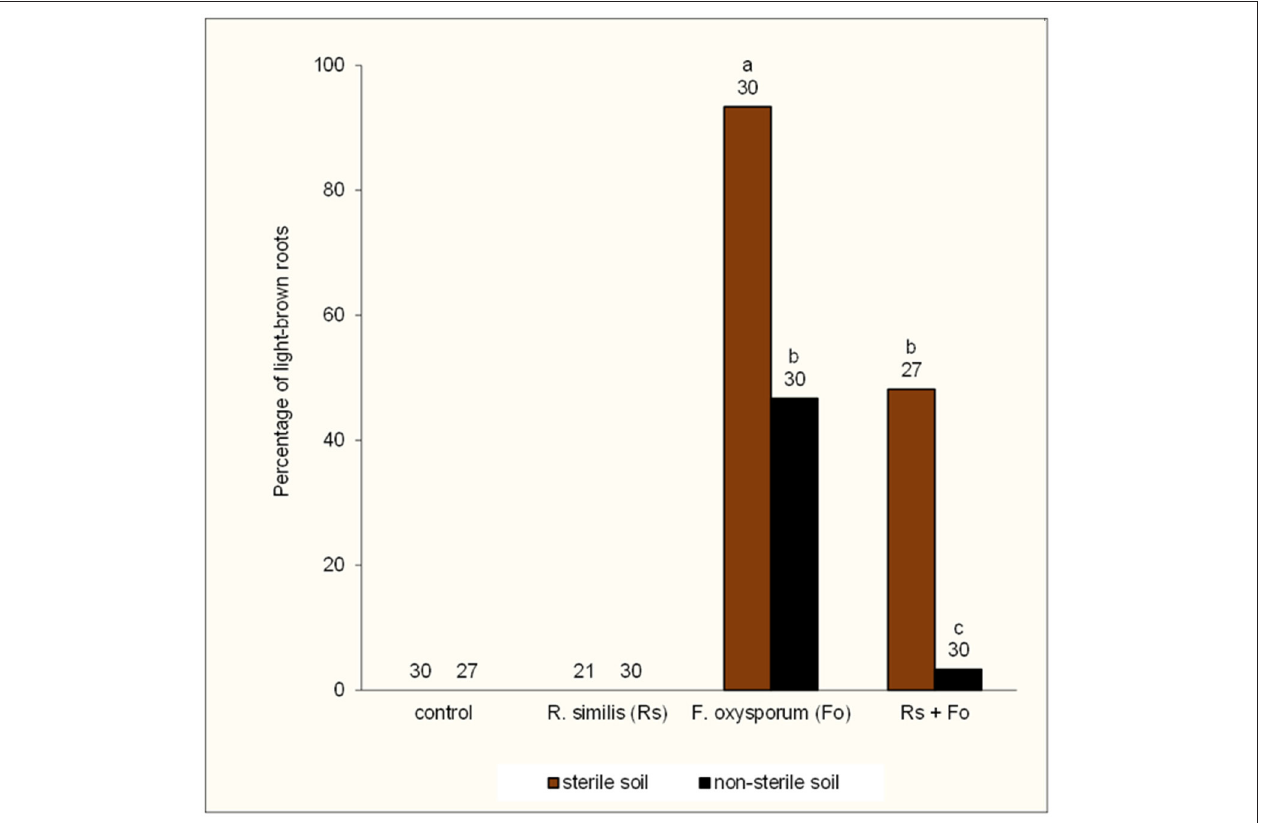
FIGURE 9 | Percentage of light-brown roots in potted tissue culture banana plants under independent or combined inoculation with Fusarium oxysporum V5w2 and Radopholus similis , and grown in either sterile soil or non-sterile soil supplied with complete nutrient solution. Bars with the same letter represent values that are not statistically different ( p > 0.05), with the sample sizes indicated below the letters (df